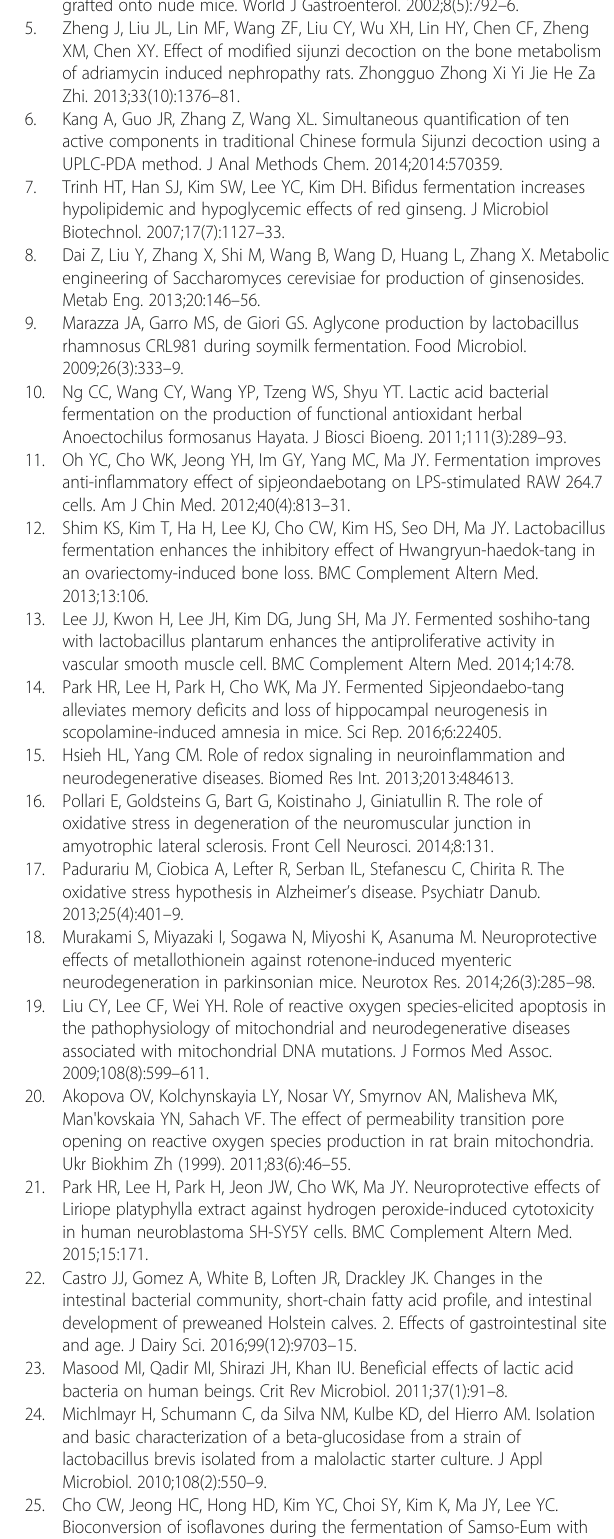
Additional file 1: Table S1. Calibration curves, limit of detection (LOD), and limit of quantification (LOQ) of the seven compounds. Table S2. Precision (intra- and interday) and accuracy of the seven compounds. Table S3. The percent recovery of the seven compounds. Table S4. Identification of the phytochemicals in SGT and SGT166 by UPLC-ESI-MS analysis. (DOCX 31